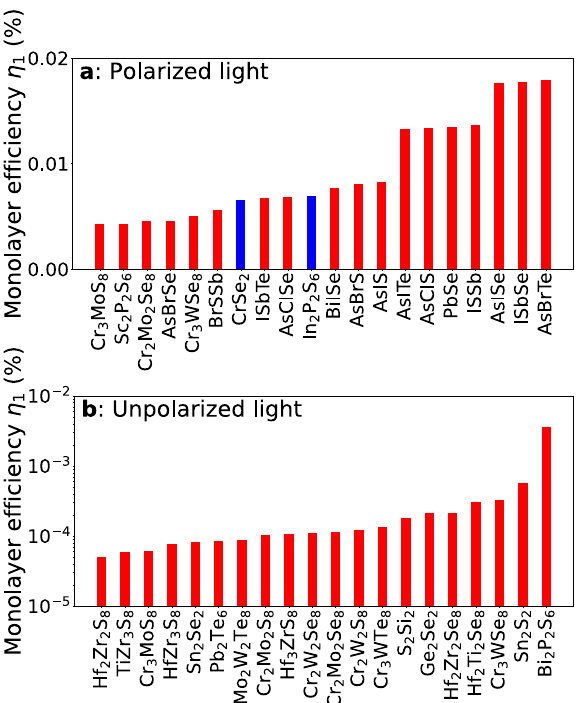
Fig. 3 Monolayer PV ef fi ciencies with phonon-limited mobilities. a , b Monolayer PV ef fi ciencies of the twenty most ef fi cient 2D materials, as calculated by Eq. (10) in the main document modi fi ed with the mobilities as calculated by the Takagi formulas (13) and (14), using parameters from C2DB and a standard solar spectrum, with and without a polarization fi lter. The color of the bars indicate polar (red) and non-polar (blue) compounds,